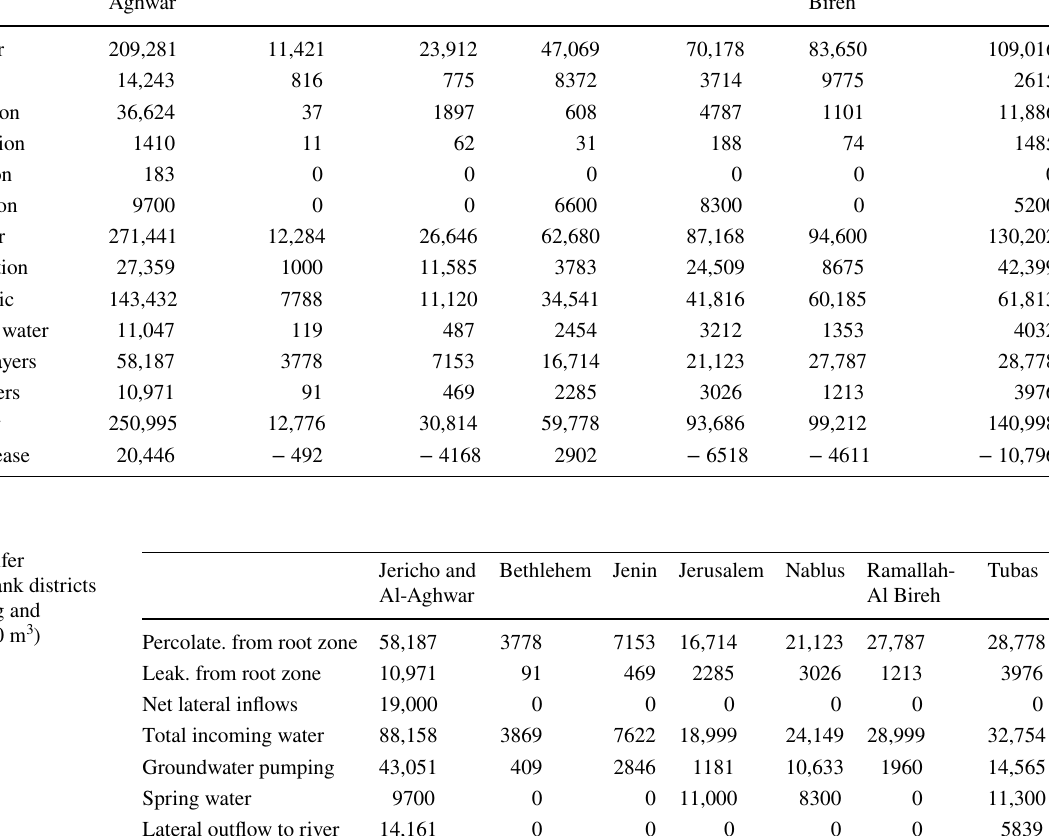
Table 3 Annual root zone balances for West Bank districts in the JRB: incoming and outgoing flows (1000 m 3 ) Jericho and Al- Aghwar